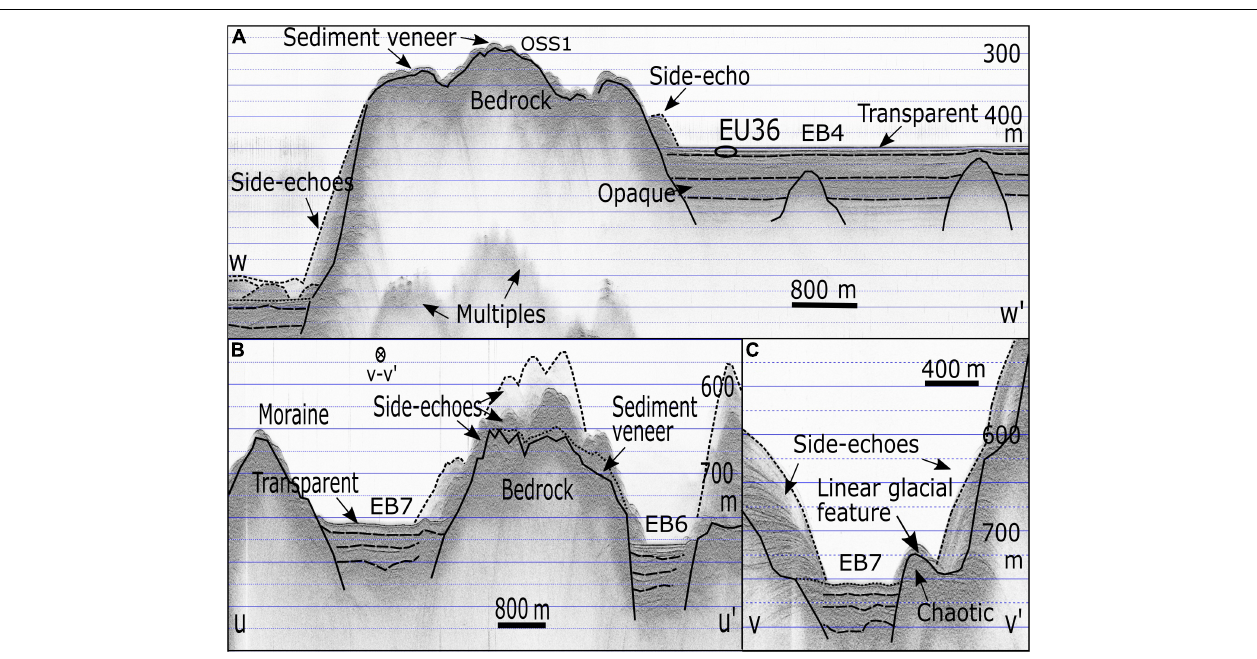
FIGURE 7 | Sub-bottom profile records from cruise NBP0505. Main seismic facies, seismic units (long segmented lines), side-echoes (short segmented lines), acoustic basements (solid lines), and other characters or processes (dotted lines) are showed. (A) Eastern subarea of the outer fjord area as showed in Figure 4A (w-w’). Projected location of the EU36 sediment core is showed. (B) Western subarea of the outer fjord area as showed in Figure 4B (u-u’). v-v’track crossing is indicated. (C) Crossing of the linear glacial feature and outer basin as showed in Figure 4B